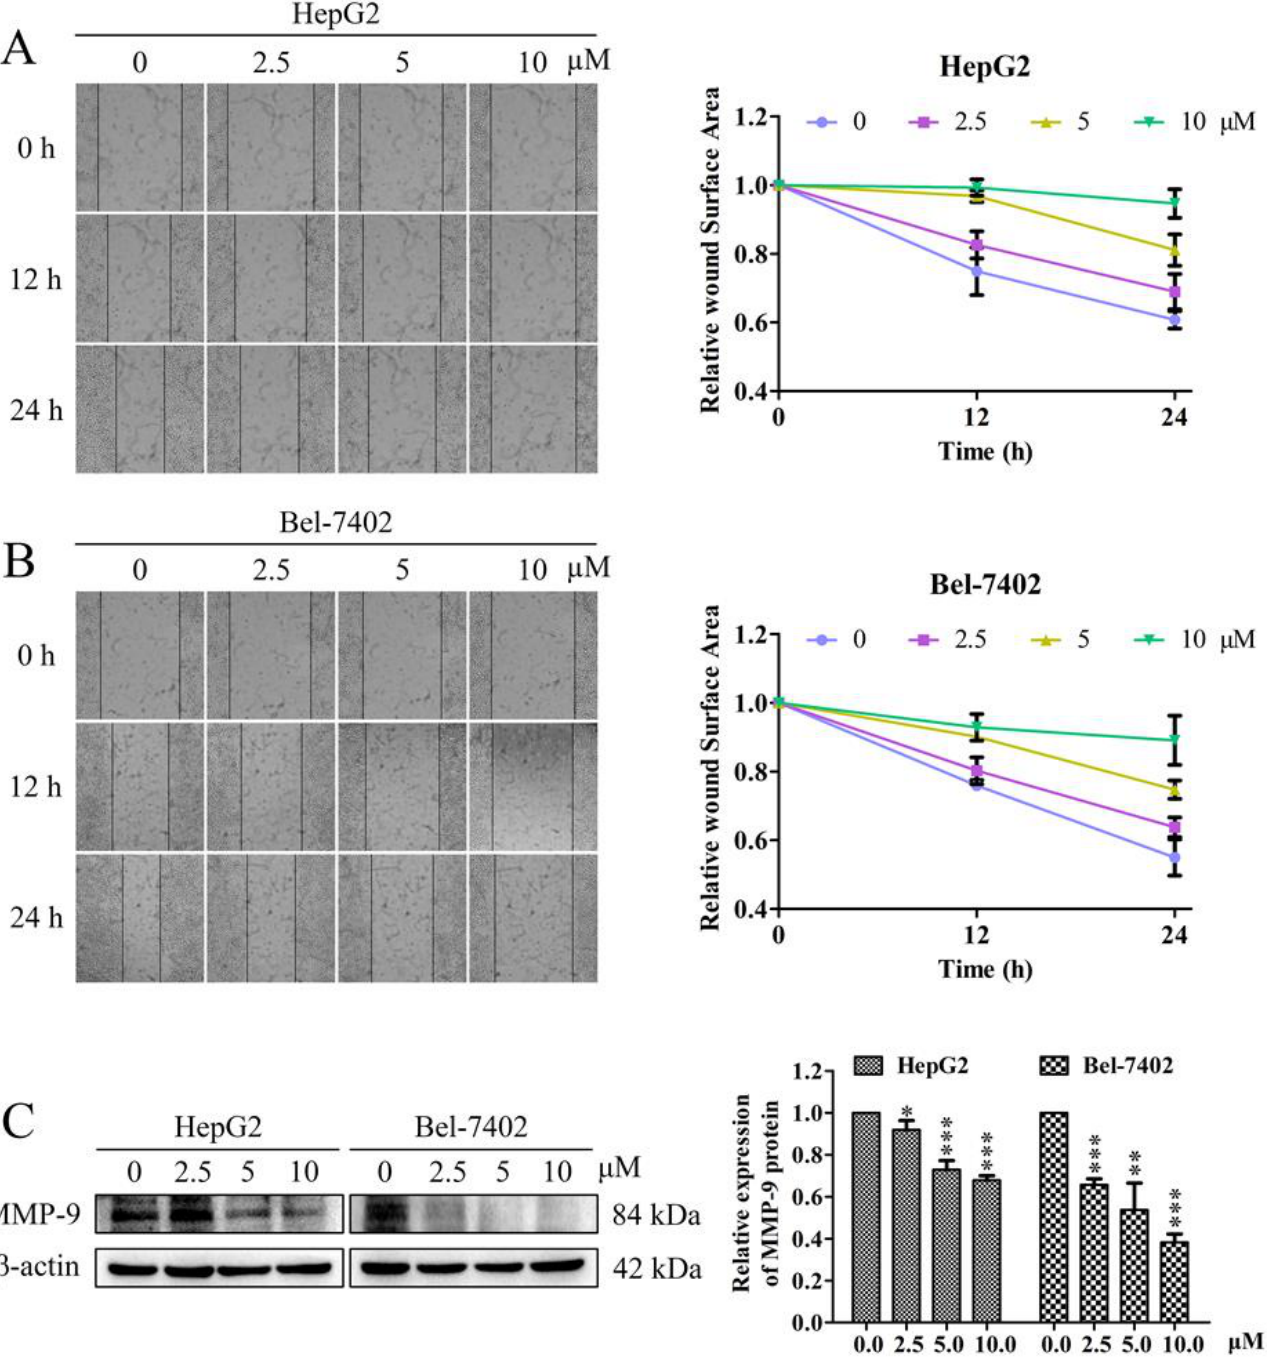
Figure 2. The inhibitory effect of davidone C on cell migration in HepG2 and Bel-7402 cells. ( A , B ) Representative images of scratch determination and counting results; ( C ) Western blot detection of MMP-9 protein expression results. (* p <0.05, ** p <0.01 or *** p <0.001).